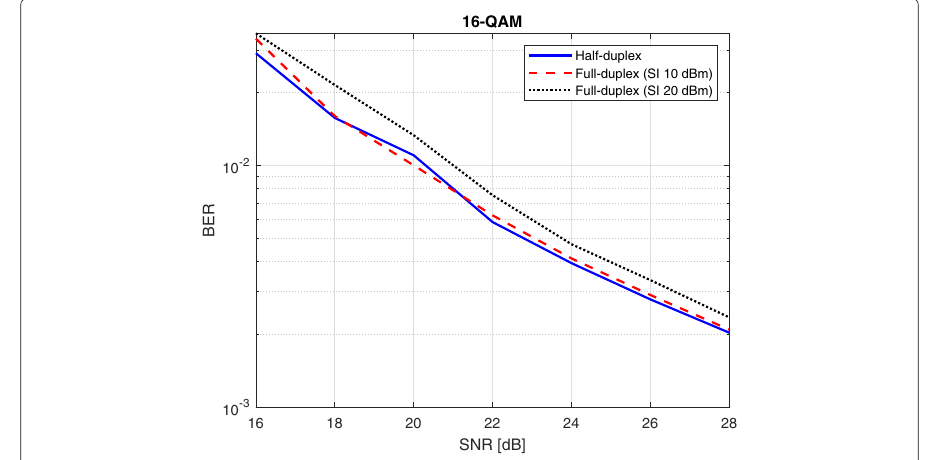
Fig. 9 BER vs. SNR in fading